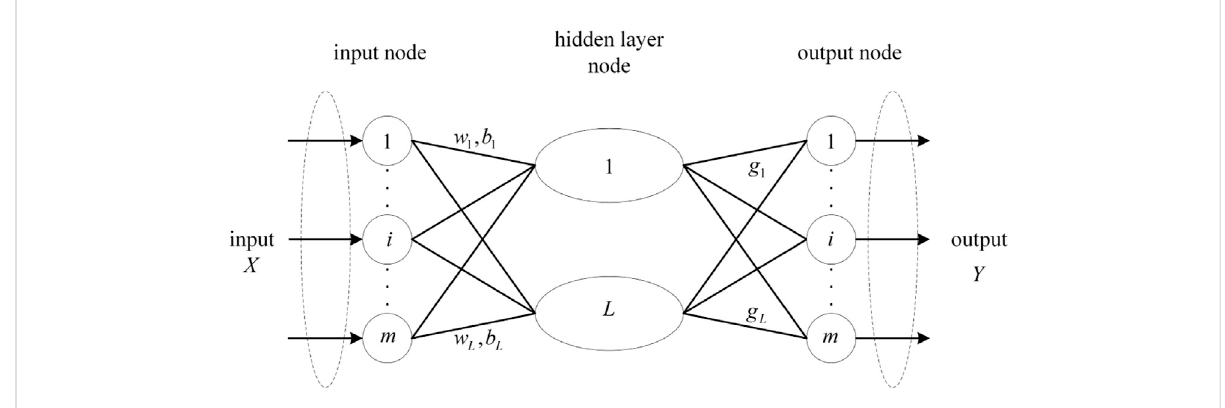
FIGURE 1 ELM-AE network structure